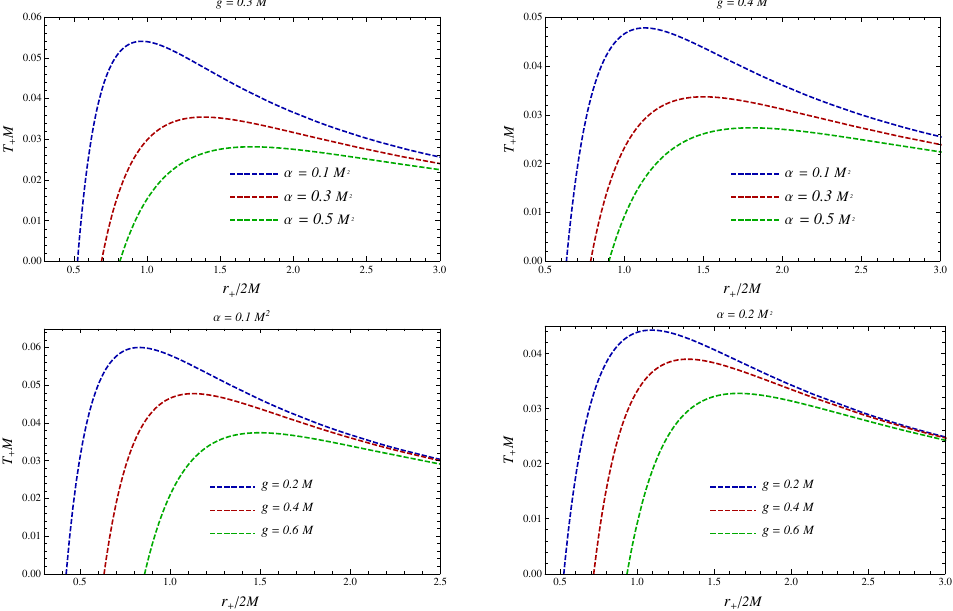
Figure 2. 4 D nonsingular EGB black holes Hawking temperature T + vs. horizon r + of for various values of α and g